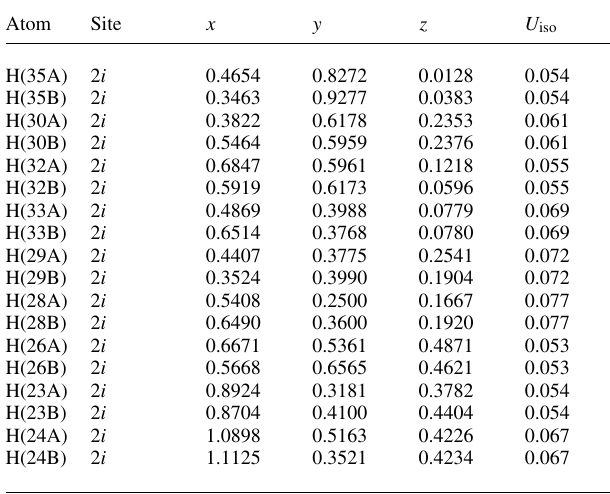
Table 2. Atomic coordinates and displacement parameters (in Å 2 )